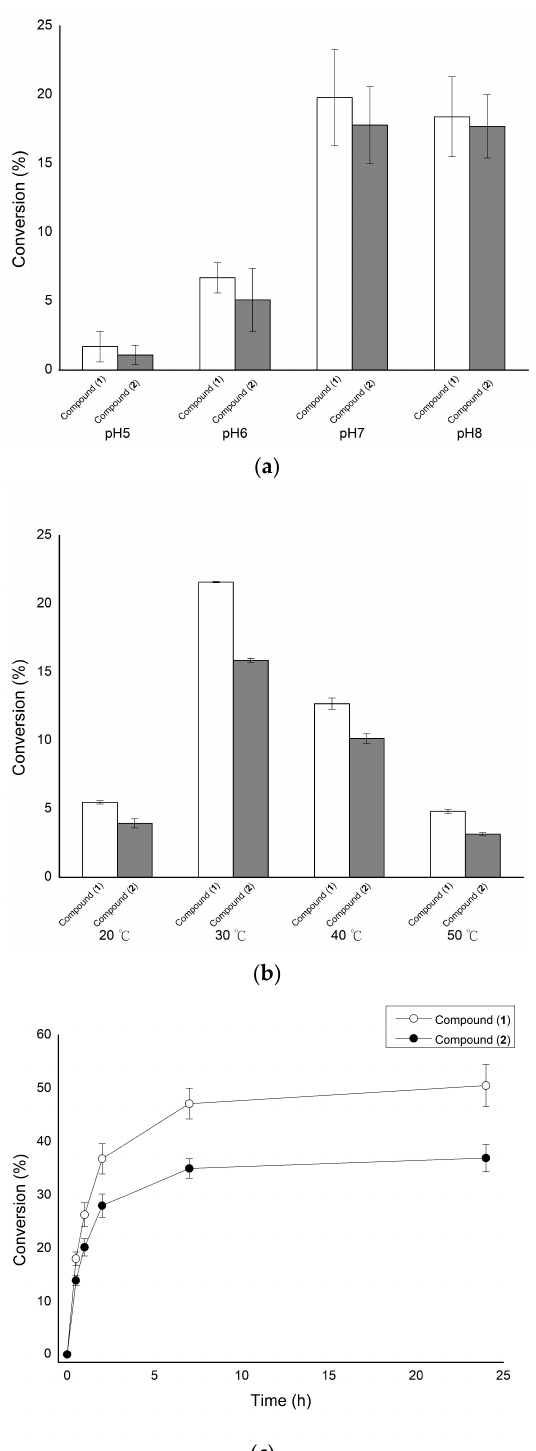
Figure 2. Effects of pH ( a ), temperature ( b ), and reaction time ( c ) on the glycosylation of vitexin by Bt GT_16345. The standard condition was set to 25 µg/mL Bt GT_16345, 1 mg/mL vitexin, 10 mM uridine diphosphate–glucose (UDP-G), 10 mM MgCl 2 , and 50 mM phosphate buffer (pH 7) at 30 °C for 30 min. To determine suitable reaction conditions, different pH values, temperatures, and reac- tion times were tested. After incubation, the biotransformation products were analyzed, using high- performance liquid chromatography (HPLC). The detailed reaction conditions and the HPLC pro- cedure are described in the Materials and Methods section.